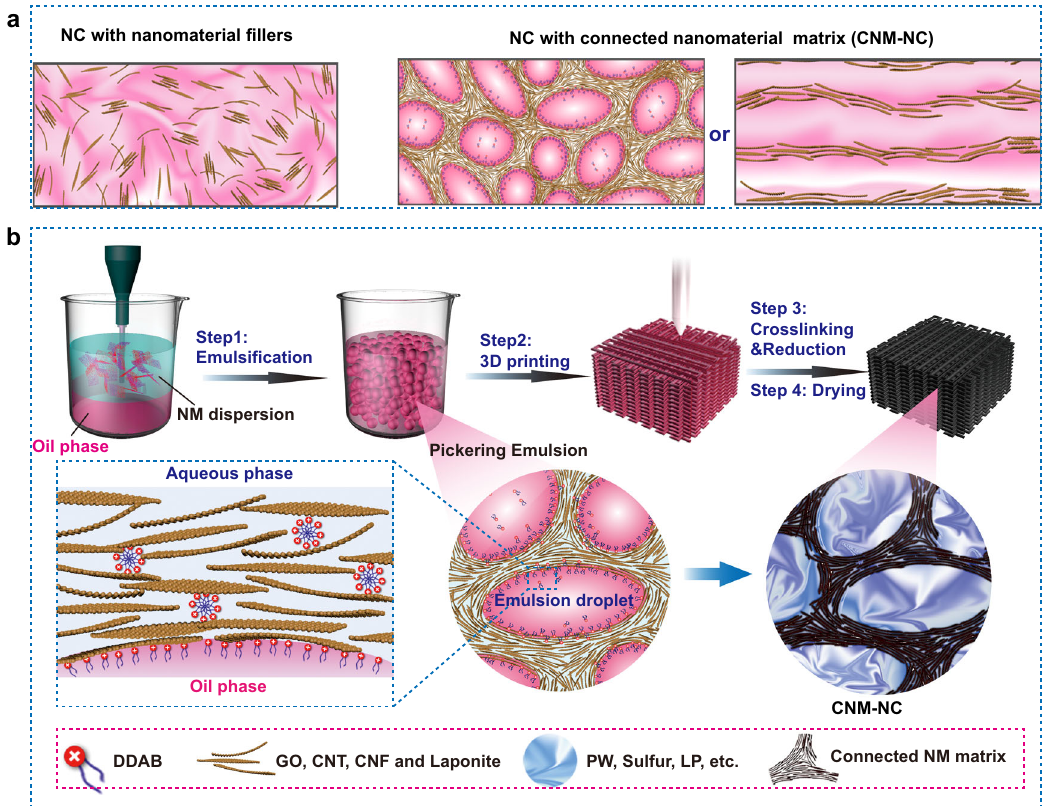
Fig. 1 Schematic illustrations of CNM-NC 3D printing. a The illustrations depict the traditional nanocomposite (NC) and NC with a connected nanomaterial matrix. b The illustration of 3D printing of Pickering emulgel. Step 1: The mixture of aqueous nanomaterial (NM) dispersion and oil were emulsi fi ed into Pickering emulgel using a homogenizer. The jamming of droplets and nanomaterials results in suitable rheology for direct ink printing. Step 2: The obtained emulgel is extruded into fi laments through a nozzle and printed layer-by-layer into various patterns. Crosslinking and the concurrently occurred reduction at step 3, as well as the following drying in step 4 are conducted to obtained stable nanocomposites. The nanocomposites allow the hybridization of water-soluble and non-water-soluble species from both